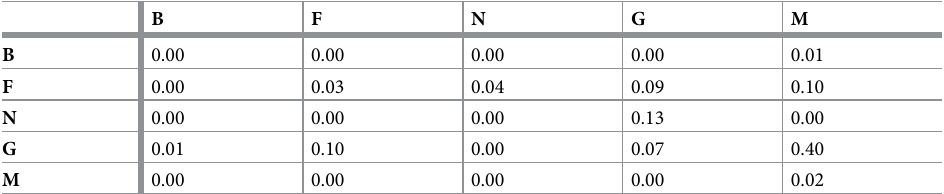
Table 1. Mixing matrix (probability of movement from row type to column type) for swine movement network [2]. The pig operation types are abbreviated as B (Boar Stud), F (Farrow), N (Nursery), G (Grower), and M (Market).